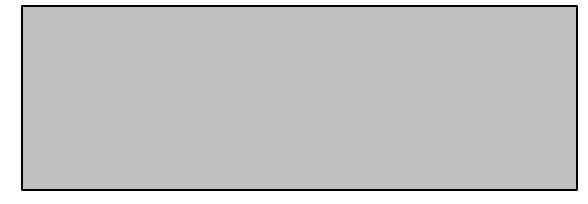
Table VI : Liver state according to alcohol use